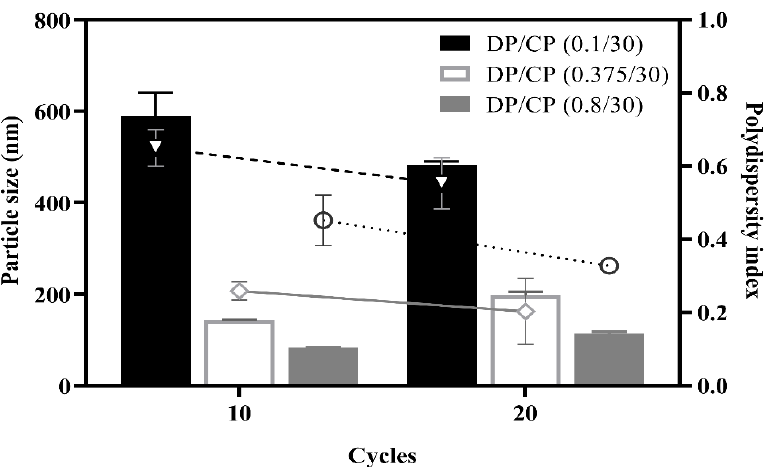
Figure 4. Effects of different ratios of the dispersed phase (DP) and continuous phase (CP) and different cycles of high-pressure homogenization on the particle size and size distribution. Column: particle size (nm); line: polydispersity index. Each point represents the mean ± SD. Error bars represent the standard deviation ( n =